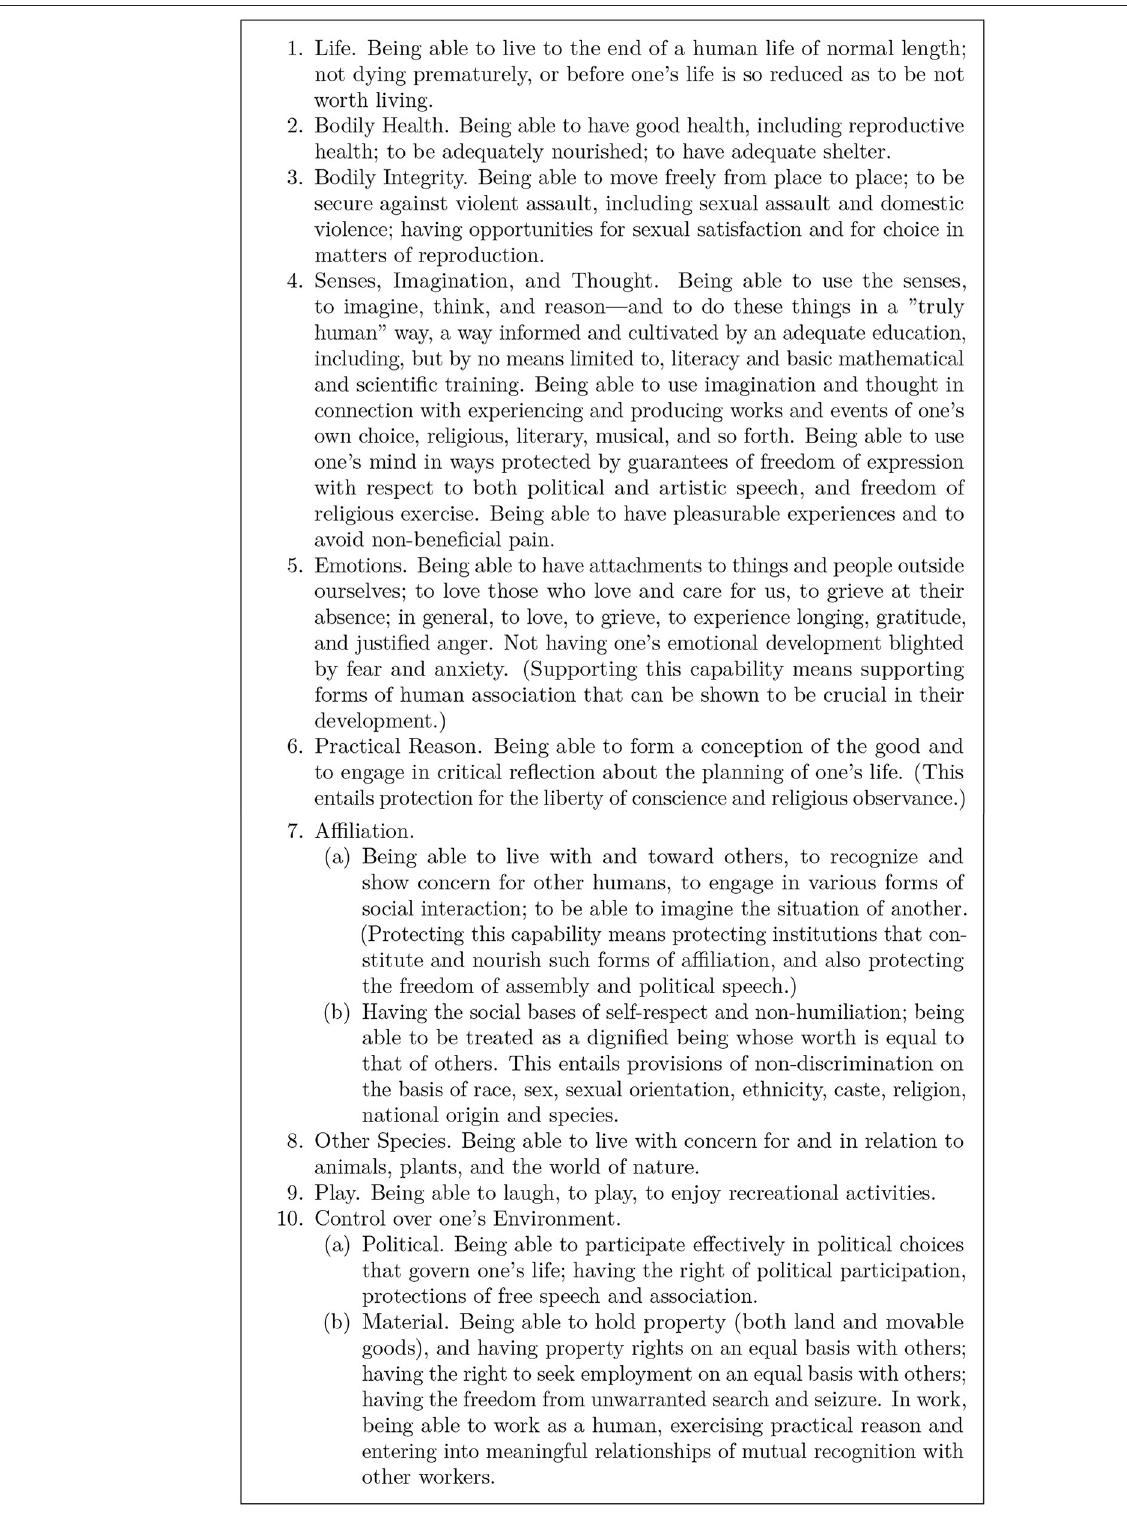
FIGURE 1 | Nussbaum’s list of central capabilities (Nussbaum, 2000, 78ff; Nussbaum, 2006, 76ff).